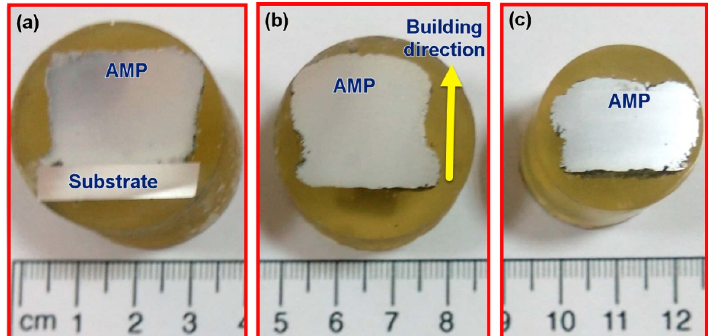
Figure 5. Cross-section macrographs of the produced A356 AMPs at 1200 rpm rotation rate and various feeding speeds ( a ) 3 mm/min, ( b ) 4 mm/min, and ( c ) 5 mm/min. Reproduced with copyright permission from Springer nature [20].